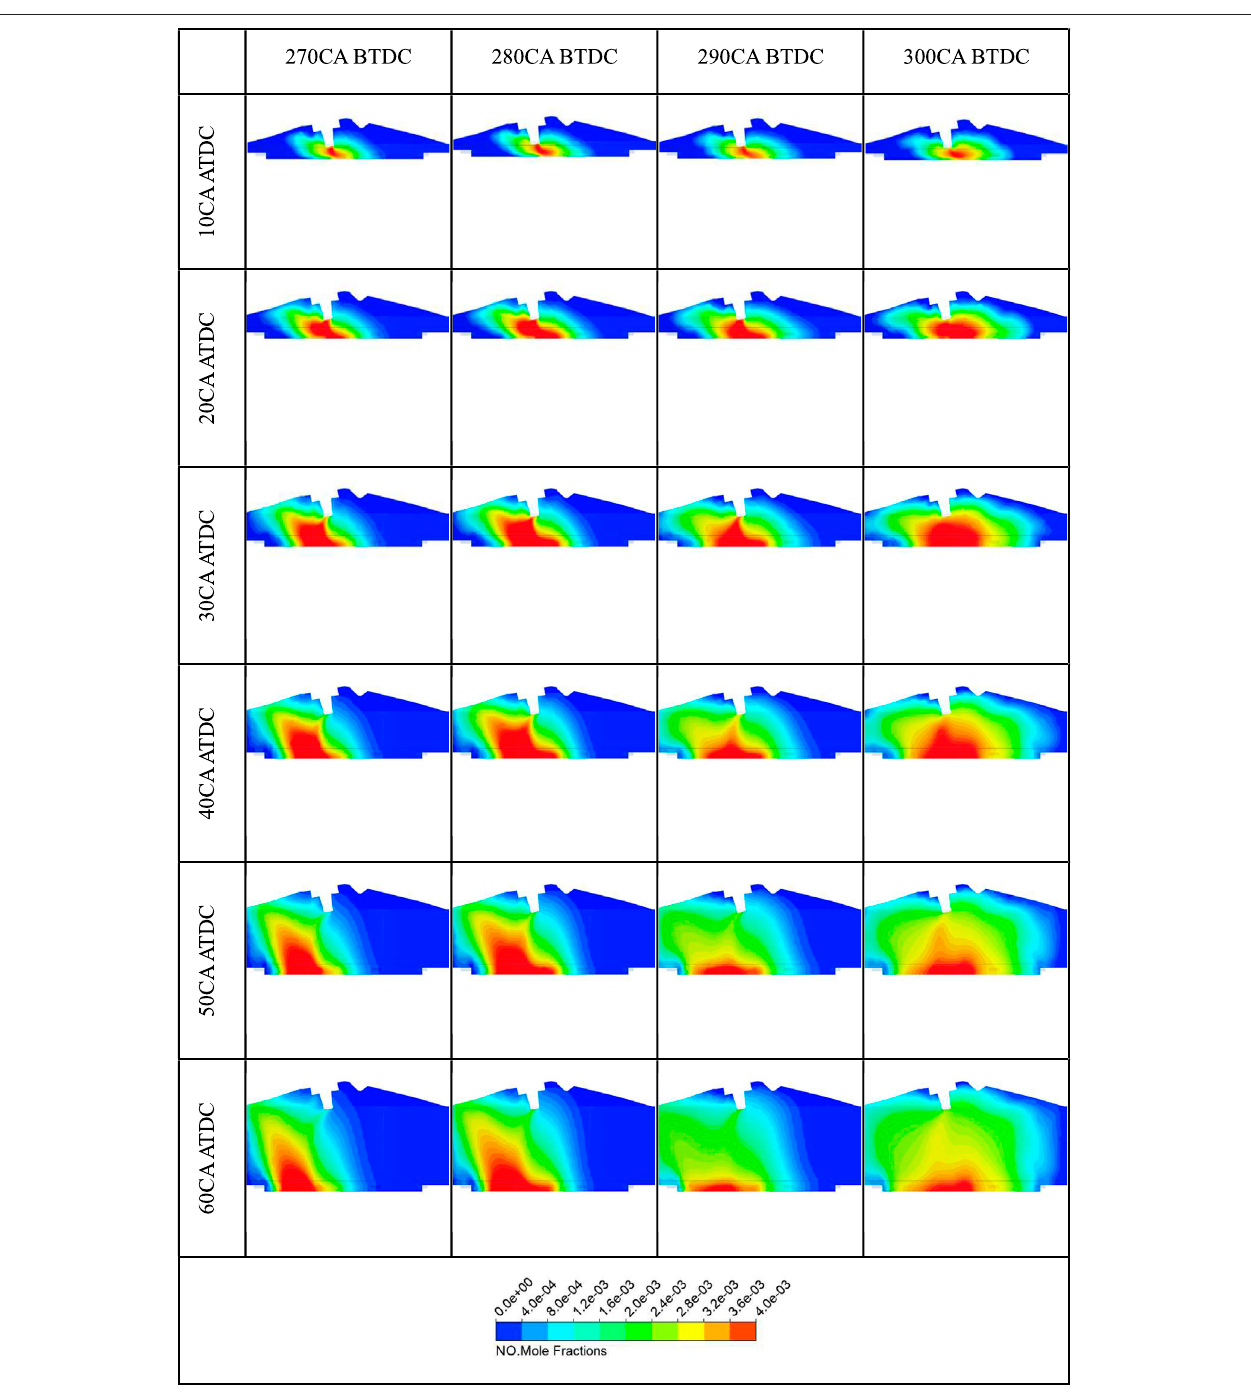
FIGURE 10 | Effect of injection timing on NOx emission at several CAD in combustion duration.